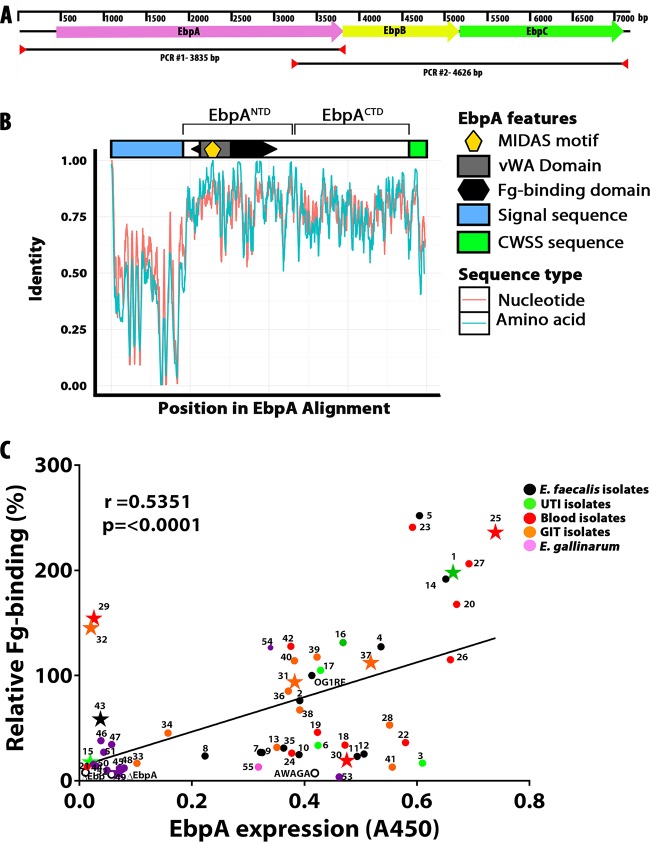
Ebp pilus operon presence and analysis of EbpA conservation and expression and of its function in binding to Fg in clinical enterococcal strains. (A) Ebp operon scheme. (B) Alignment of 137 unique EbpA peptide and nucleotide sequences by using a hidden Markov model. vWA, von Willebrand factor A. (C) Pearson correlation statistical analysis was performed to measure the correlation between EbpA expression and Fg binding of each tested enterococcal strain (n = 3). Each dot represents the average of results from two independent experiments, each consisting of 3 biological replicates. As a negative control for the expression of EbpA, ΔEbp pilus and ΔEbpA strains were used, and as a negative control for Fg binding, the EbpA MIDAS mutant strain (AWAGA) was used. The star symbols indicate the strains that were selected for additional in vivo analyses.